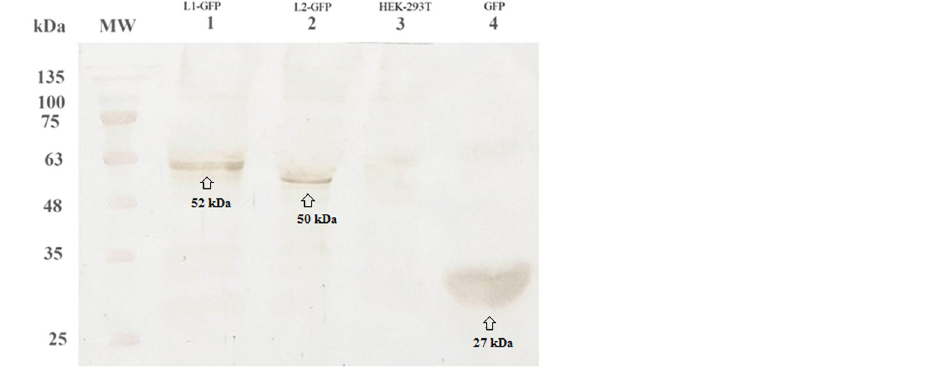
Figure 4. Identification of protein expression in HEK-293T cells using western blot analysis. The clear bands were observed for L1-GFP (lane 1, ∼ 52 kDa), L2-GFP (lane 2, ~50 kDa) and GFP (lane 4, ~27 kDa) proteins, respectively. Any clear band was not detected in un-transfected cells as a negative control (lane 3). MW is molecular weight marker (prestained protein ladder, 10–170 kDa,